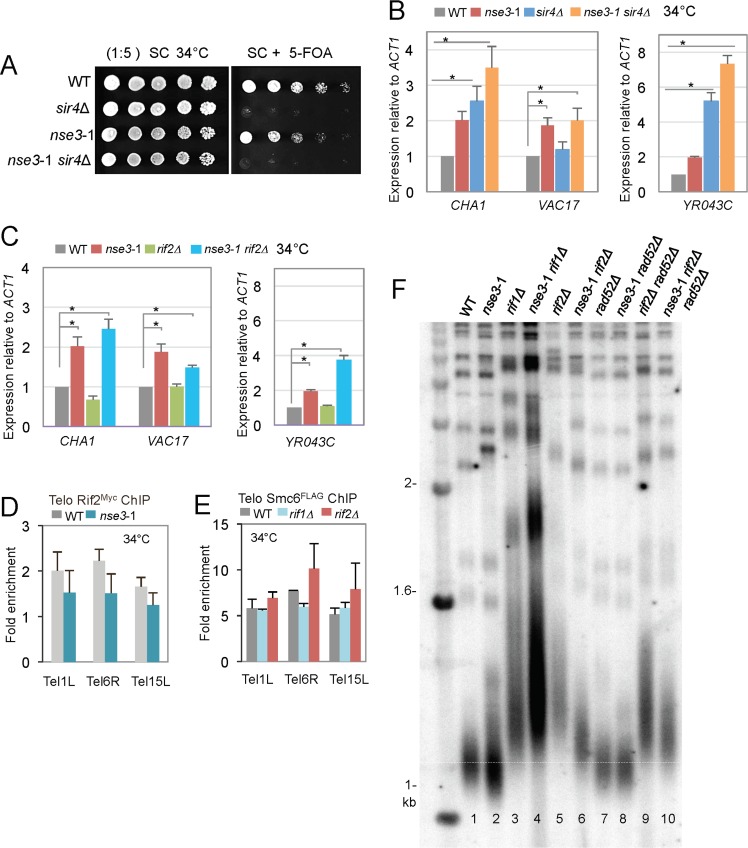
The nse3-1 allele exhibits genetic interactions with the loss of SIR4 and RIF2.(A) TPE was determined in strains with the URA3 reporter at the adh4 locus of Chromosome VIIL as in Fig 3E. Overnight cultures were spotted onto SC (complete medium) and SC + .1% 5-FOA plates at 34°C in wild type (JC1991), sir4Δ (JC3818), nse3-1(JC3860), nse3-1 sir4Δ (JC3870) isogenic strains. (B) Transcription levels in wild type (JC470), nse3-1 (JC3607), sir4Δ (JC3737), and nse3-1 sir4Δ (JC3741), and (C) rif2Δ (JC2992) and nse3-1 rif2Δ (JC3269) at sub-telomeric genes CHA1 and VAC17 on Tel3L and YR043C on Tel9R as described in [62, 63]. Expression values are mRNA levels relative to ACT1 and normalization to wild type cells. Error bars represent ± SD of n = 3 experiments with p values < .05 from a two-tailed t-test indicated by (*). (D) Chromatin immunoprecipitation (ChIP) was performed on Rif2Myc and showed similar levels of recovery in wild type (JC2380) and nse3-1 (JC3235) mutants. (E) ChIP on Smc6FLAG in wild type (JC1594), rif1Δ (JC2754) and rif2Δ (JC3074) cells with enrichment levels for untagged strains in wild type and mutants shown in S5C and S5D Fig. The mean ± SD of the fold enrichment at three native subtelomeres (Tel1L, Tel6R and Tel15L) relative to the control (ctrl) late replicating region on Chromosome V (469104–469177) is reported. In rif2Δ mutants the p values < .05 = 0.53 (Tel1L), 0.13 (Tel6R), and 0.15 (Tel15L) indicated that the difference was not significant from wild type. (F) Telomere length was determined as previously described [15]. Southern blot analysis was performed on 1μg XhoI-digested genomic DNA hybridized with a radiolabeled poly (GT/CA) probe in wild type (JC470), nse3-1 (JC3607), rif1Δ (JC3448), nse3-1 rif1Δ (JC3623), rif2Δ (JC2992), nse3-1 rif2Δ (JC3269), rad52Δ (JC1427), nse3-1 rad52Δ (JC3629), rif2Δ rad52Δ (JC3603), and nse3-1 rad52Δ rif2Δ (JC3627) strains.